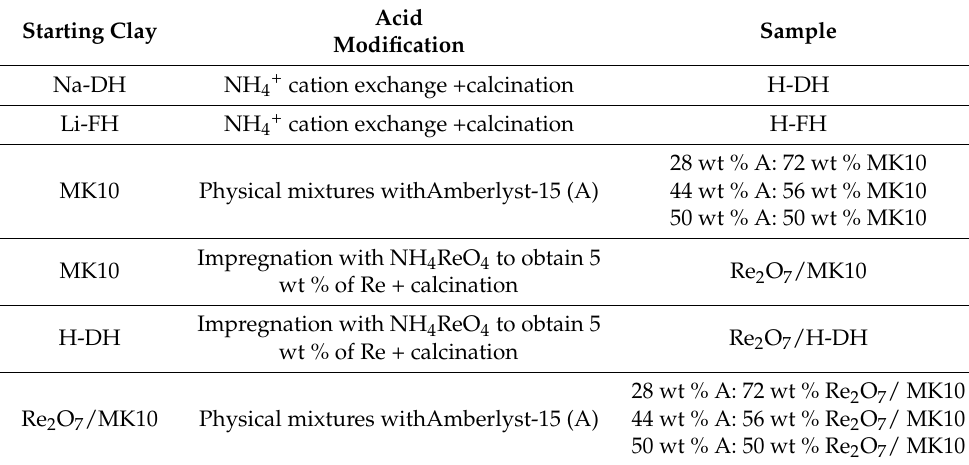
Table 1. Methodologies for the acid modification of the clays.